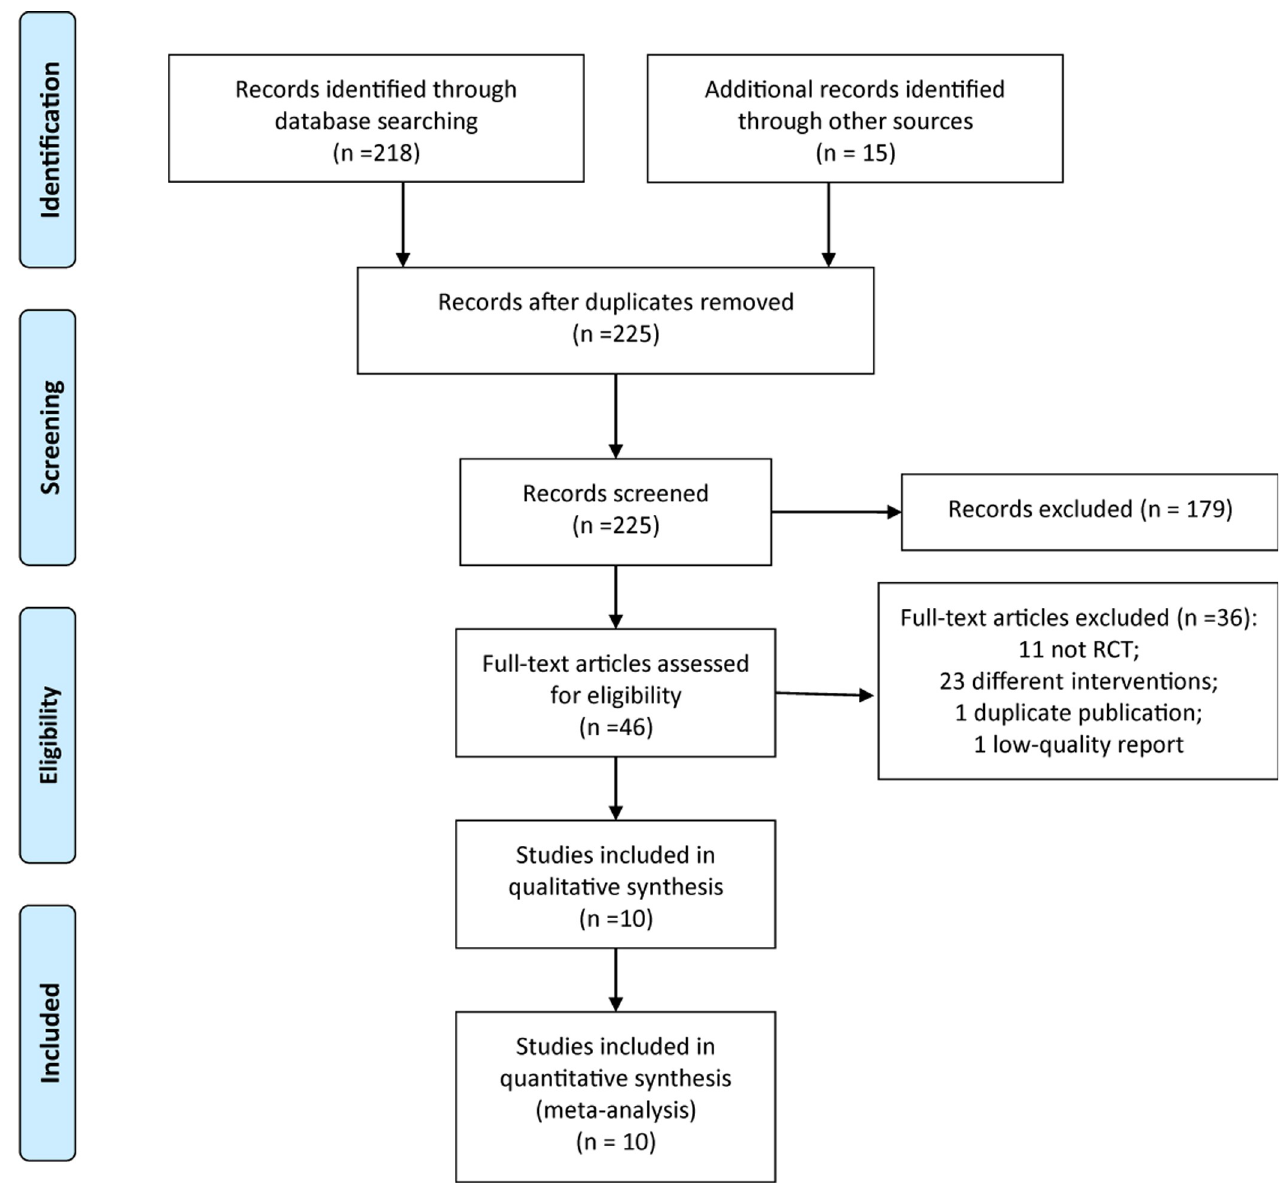
Fig 1. The PRISMA flow diagram of study